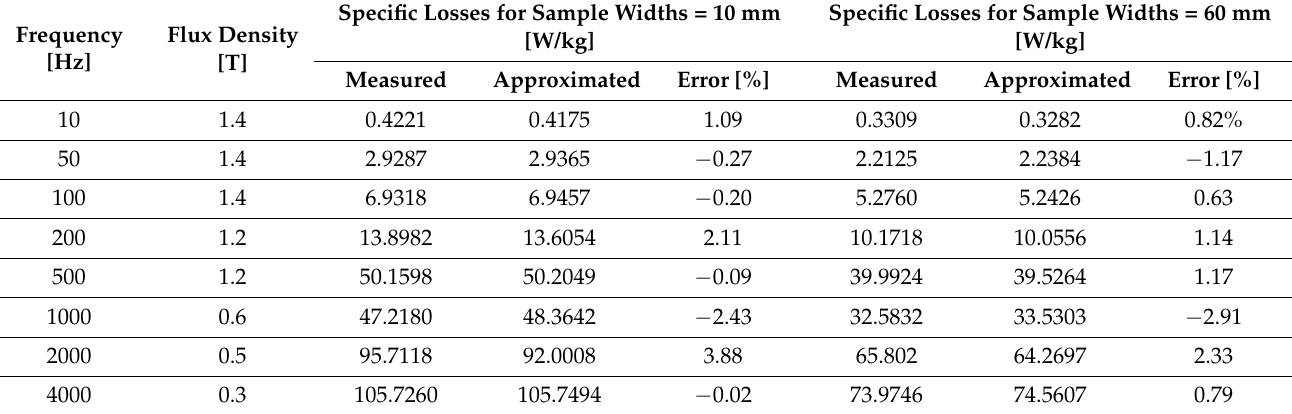
Table 6. Exemplary the differences between experimental and simulation results for the M270-35A sheet cut with a